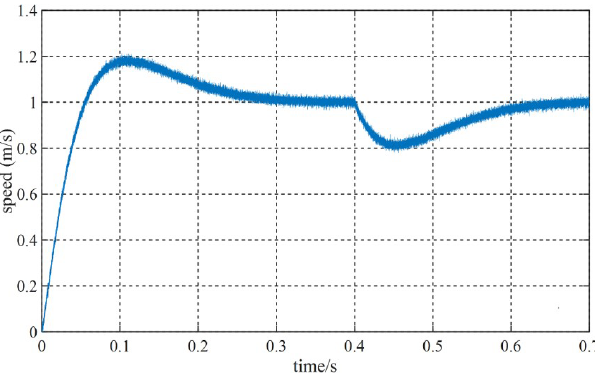
Figure 19. Bar chart of settling time for two controllers during load motion.